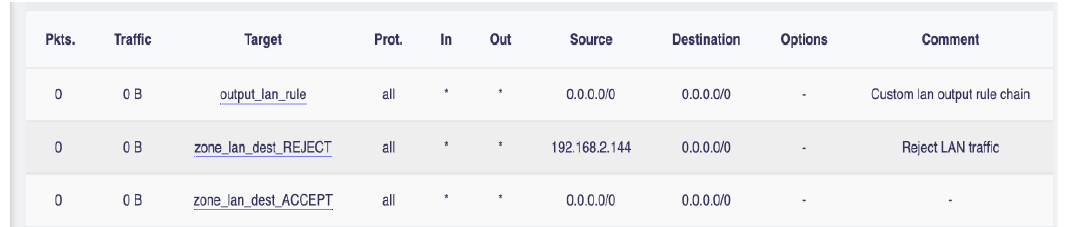
Figure 7. Abnormal traffic originating from a malicious device is blocked by the router.